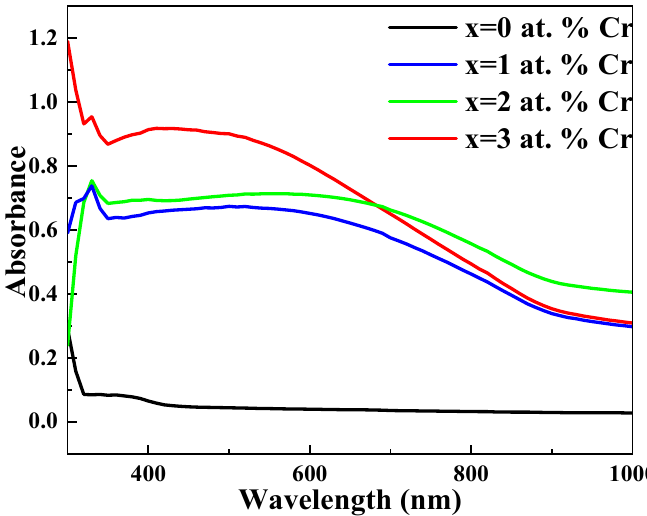
Figure 4. Absorbance spectrum of undoped and Cr-doped Bi 2 S 3 thin films. Table 2. Optical parameters of selected samples calculated by UV-vis spectroscopy at 535 nm. Parameters